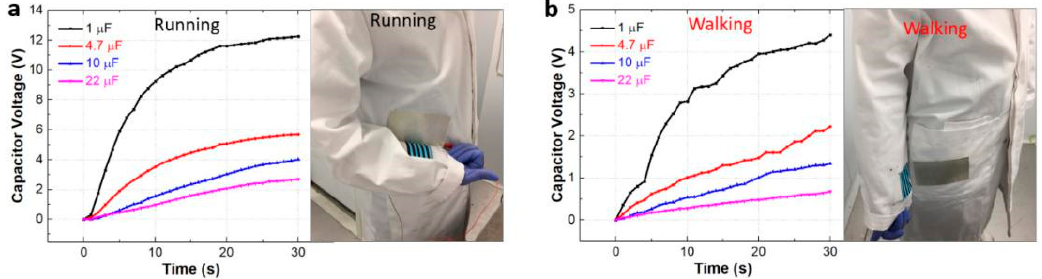
Figure 4. Capacitor voltage of the pnG-TENG as a function of time for different capacitors charged by ( a ) running and ( b ) walking.